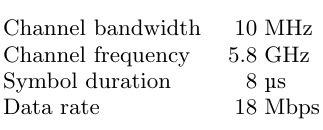
Table 2: Simulation parameters.